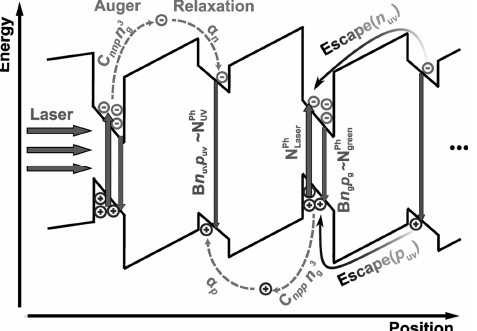
Figure 3. Schematic drawing of the band structure of sample containing alternating green and UV QWs. UV quantum wells are used to capture hot charge carriers generated by Auger processes in the green wells. Luminescence originating from the UV wells therefore visualizes Auger recombination in the green wells. This figure is reprinted from Ref. [52], with the permission of AIP Publishing LLC. PDPL is a direct evidence that droop can be originated from the internal loss. However, it only validates the internal loss indeed exists in InGaN QW when carrier concentration is high enough. It cannot fully verify the droop appearing in LED EL is the internal loss exactly. There are two concerns. First, the energy bands in PL and EL measurement are different, wherein the former is no-bias while the latter is under forward bias. Second, the excitation power in PL cannot corresponds to injection current in EL directly. Both of them need to transform to carrier concentration according to carrier lifetime. From publications, we can know that the droop in PDPL occurs when excitation power density is higher than 100 MW/cm 2 [48], but the onset point of EL droop is usually below 10 A/cm 2 [6]. Thus, there exists a possibility that the onset of droop in EL is before the onset of droop in PL if we compare their carrier concentration.